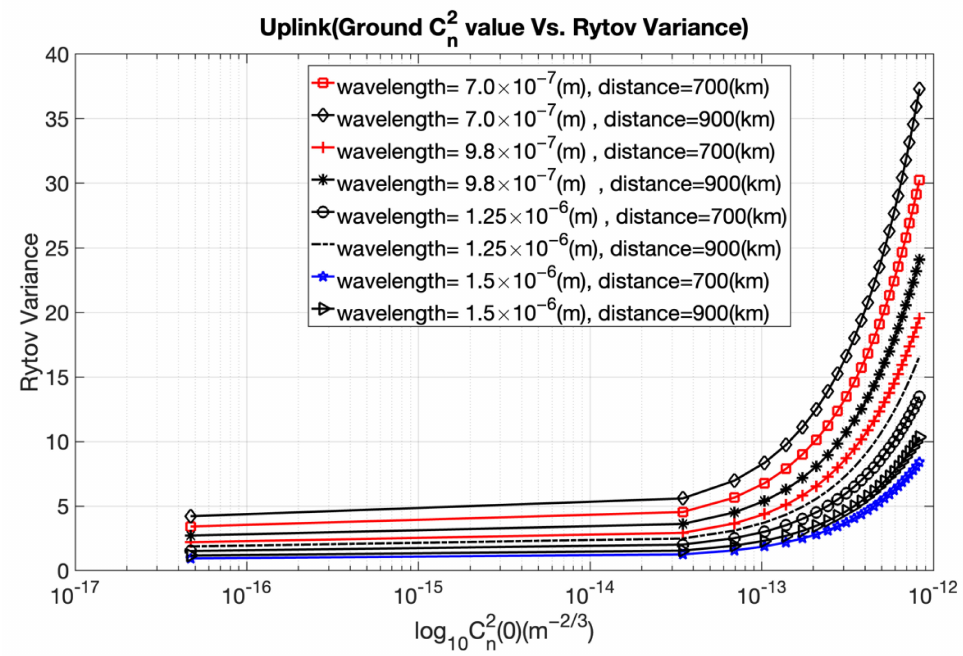
Figure 4. Variation in the Rytov variance in an uplink channel.